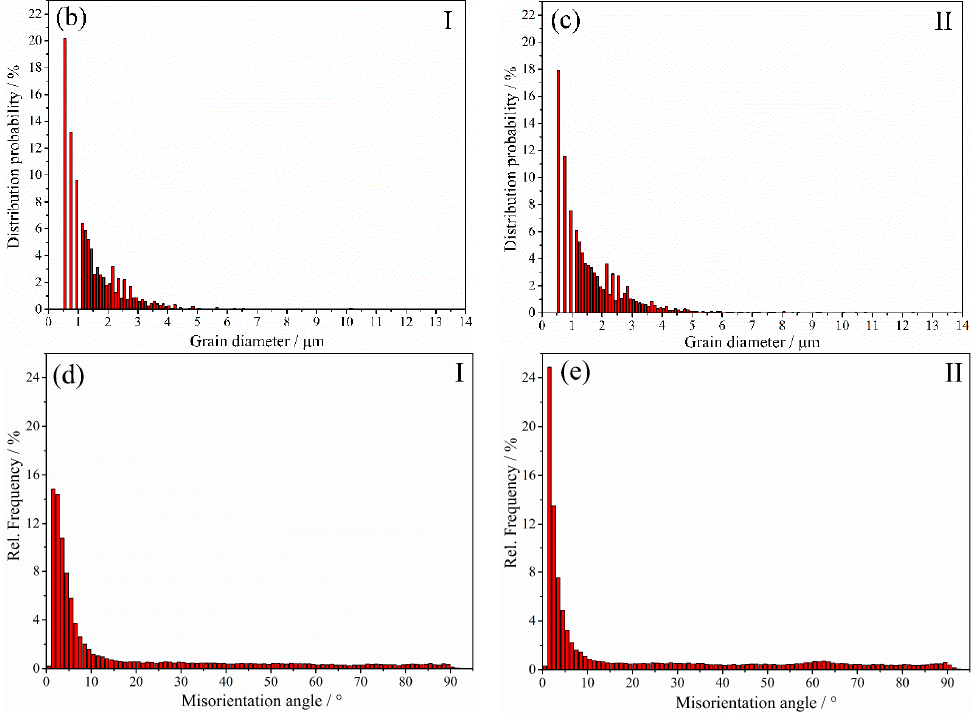
Figure 5. Cross-sectional EBSD map of Ti-6Al-4V alloy treated by the USRP ( a ); and corresponding grain diameter distribution ( b , c ) and misorientation angle distribution ( d , e ): Ι zone—the near surface; ΙΙ zone—the sub-surface.